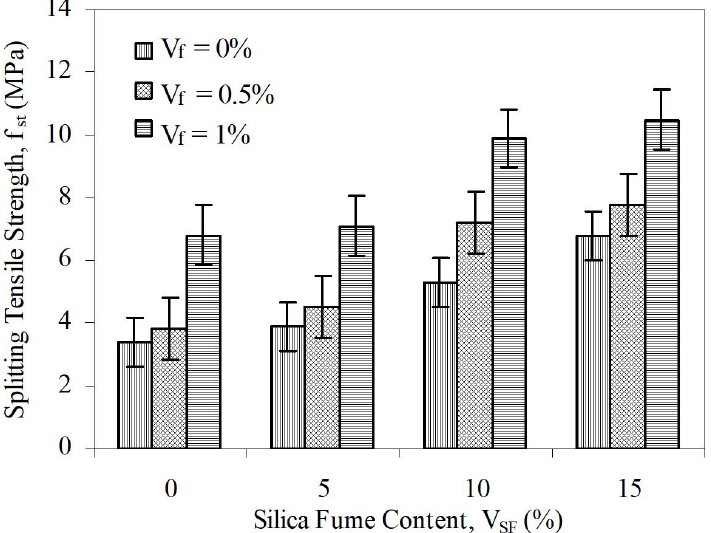
Figure 7. The relation between f st and V SF at different V f for L/d = Figure 5. Load–deflection graphs of SFRCs for V f = 1% and aspect ratio of 80.